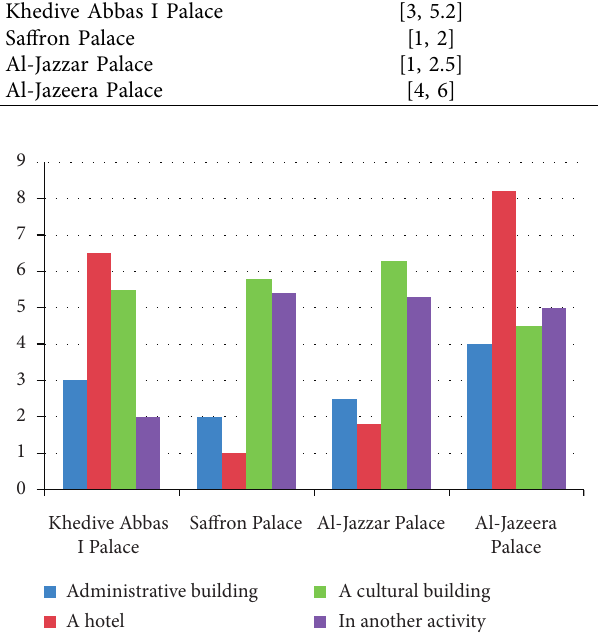
Figure 6: Graph indicating the extent of approval of the new activity of the building according to the view of the surrounding environment and users.